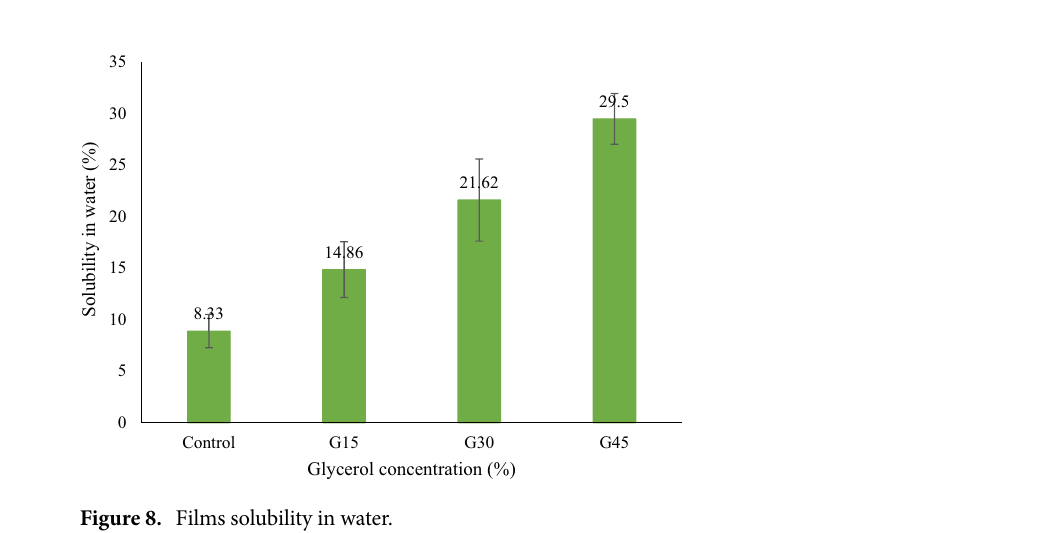
Figure 8. Films solubility in